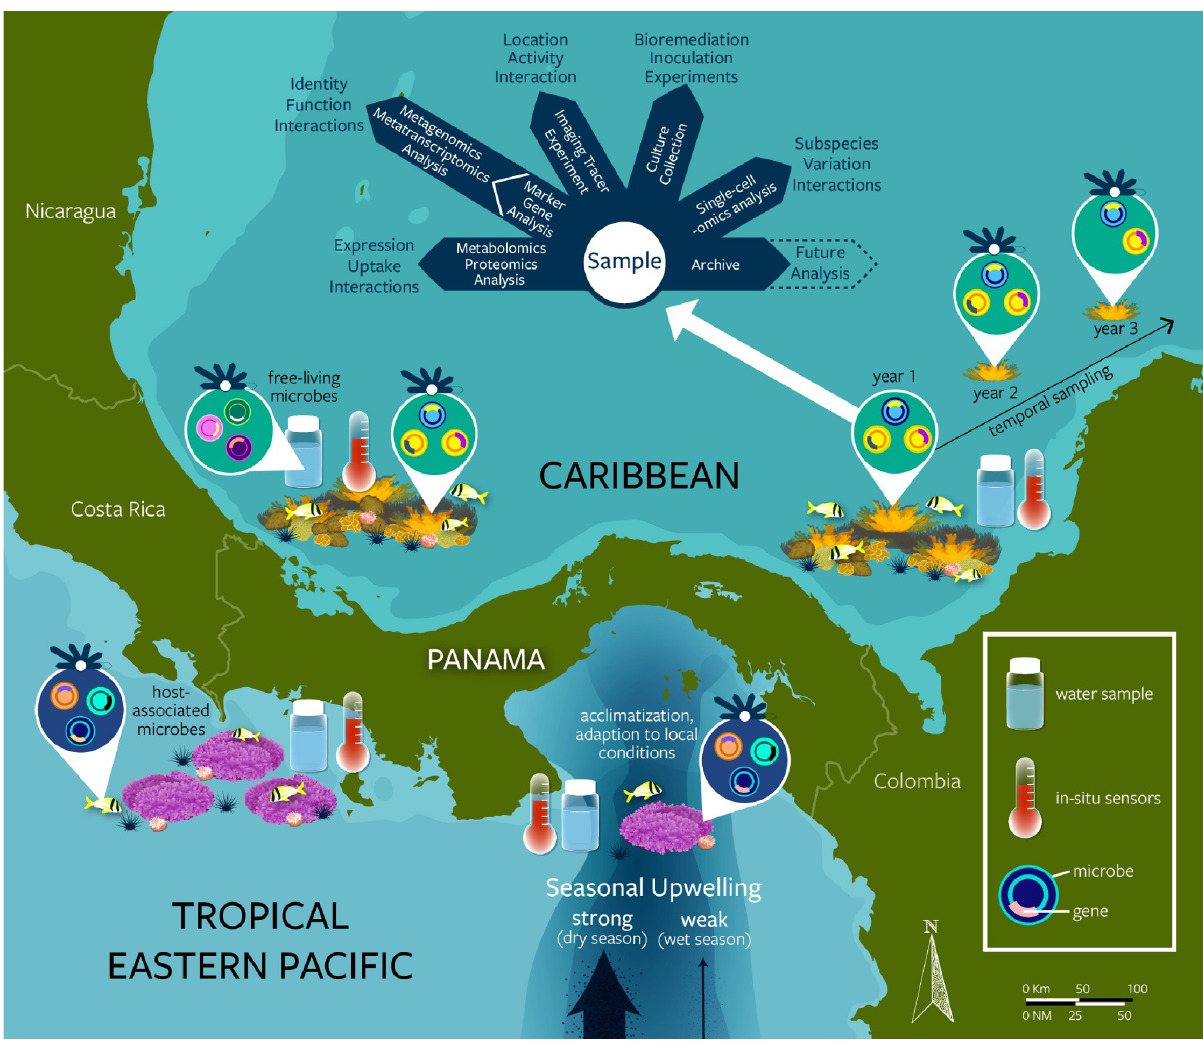
Fig 4. Methodological approach to leveraging a natural experiment, the Isthmus of Panama, for the long-term study of host–microbe ecology and evolution. Present-day organisms physically separated by the Isthmus of Panama are adapted to the distinct environmental conditions of the productive TEP and the oligotrophic Caribbean. In the Gulf of Panama of the TEP, organisms experience some of the most drastic annual fluctuations in temperature, pH, oxygen, salinity, and nutrients, due to intense seasonal upwelling. Conversely, the nearby Gulf of Chiriquı´of the TEP experiences weak to no upwelling due to trade winds being largely blocked by the Cordillera Central mountain range. Multidisciplinary and long-term research on hosts and associated microbes across these environmental spatiotemporal gradients, where decades of taxonomic, ecological, and evolutionary research can be leveraged, will help capture the dynamics of host–microbe interactions. TEP, Tropical Eastern